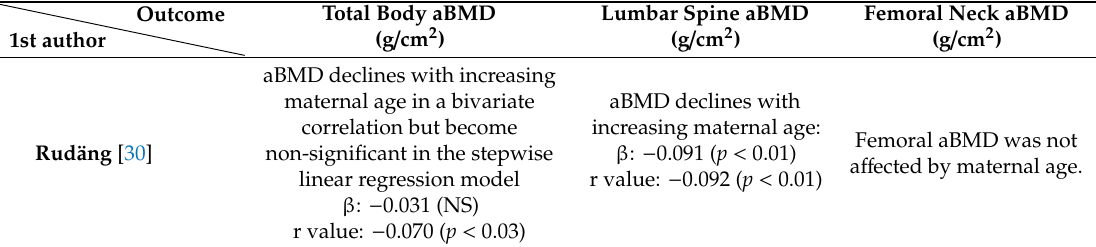
Table 5. Association between the maternal age at birth and the o ff spring bone mineral density in